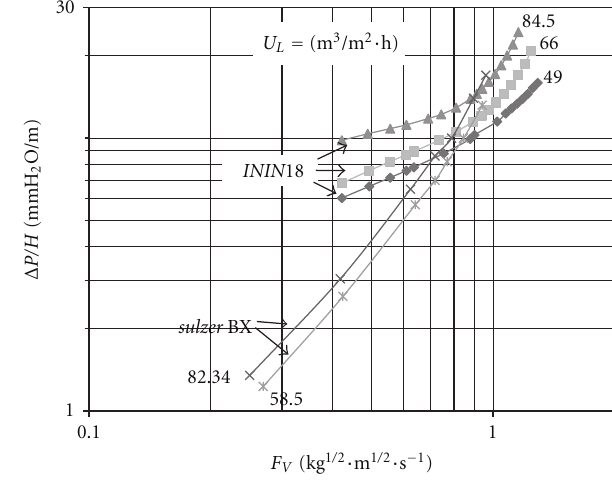
Figure 3: Pressure drop versus the gas capacity factor.